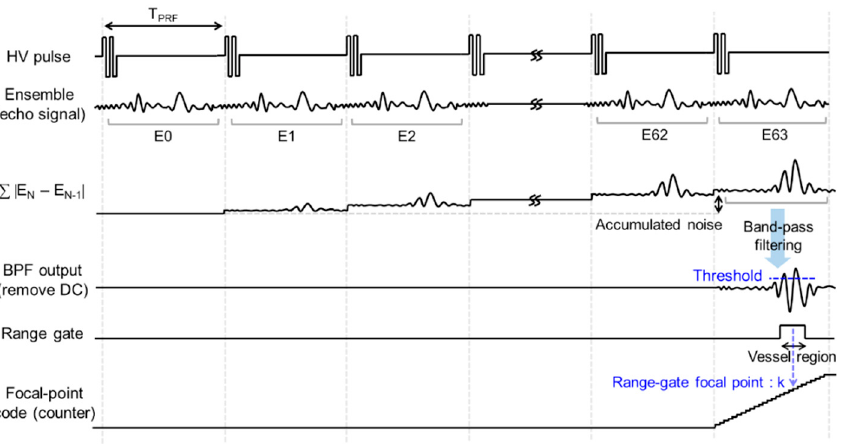
Figure 6. Timing diagram of automatic range-gate-positioning scheme; HV: high voltage; PRF: pulse repetition frequency; BPF: band-pass filter, DC: direct current.